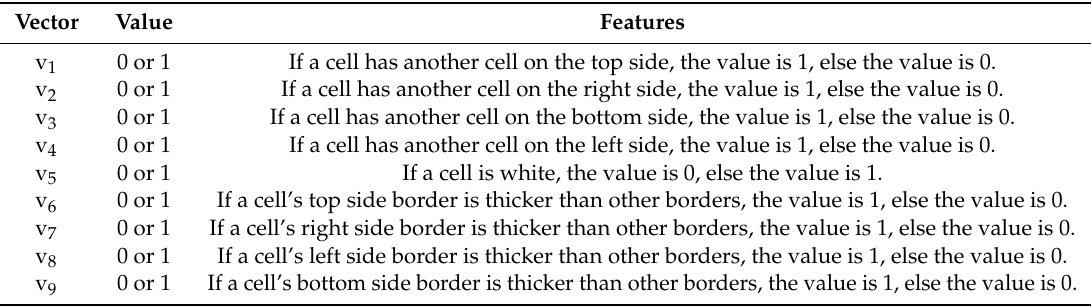
Table 2. Description of geometry feature vector representation.